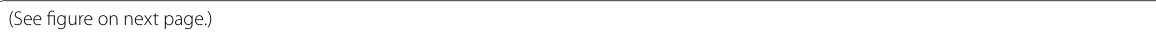
figure on next Fig. 3 Common- and variety-specific biological process enrichments of salt stress regulated DEGs. A . Biological process enrichment of commonly up-regulated genes in all three rice varieties. B . Biological process enrichment of commonly up-regulated genes in ‘C34’ and ‘NB’. C . Biological process enrichment of ‘NB’ specific up-regulated genes. D . Biological process enrichment of ‘C34’ specific up-regulated genes. E. Biological process enrichment of down-regulated genes in salt-tolerant rice varieties, ‘C34’ and